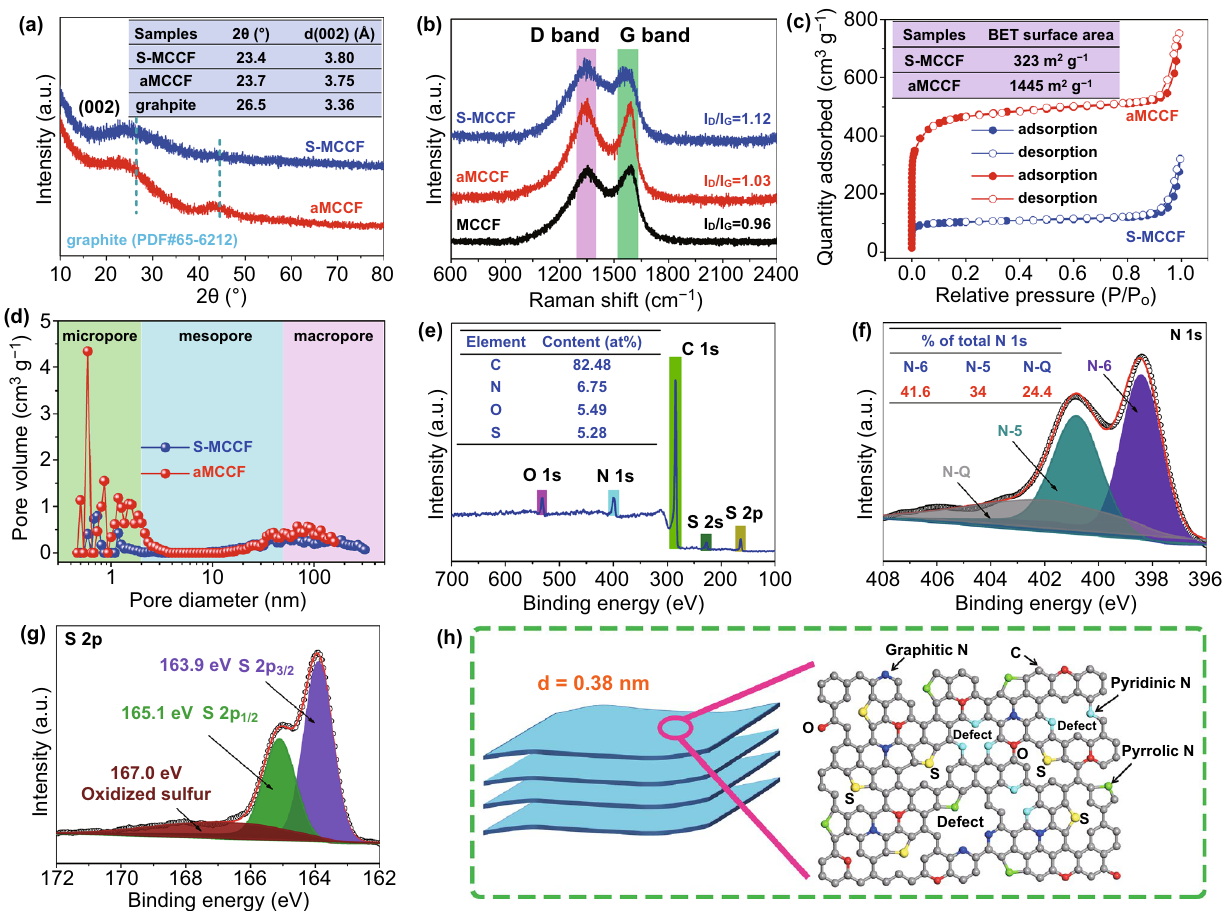
Fig. 2 Characterization of S-MCCF and aMCCF: a XRD patterns, b Raman spectrum, c N 2 adsorption–desorption isothermal curves, d pore size distributions, e XPS survey spectra corresponding to the S-MCCF and the high-resolution spectrum of f N 1 s and g S 2p. h Schematic of the atomic structure of the